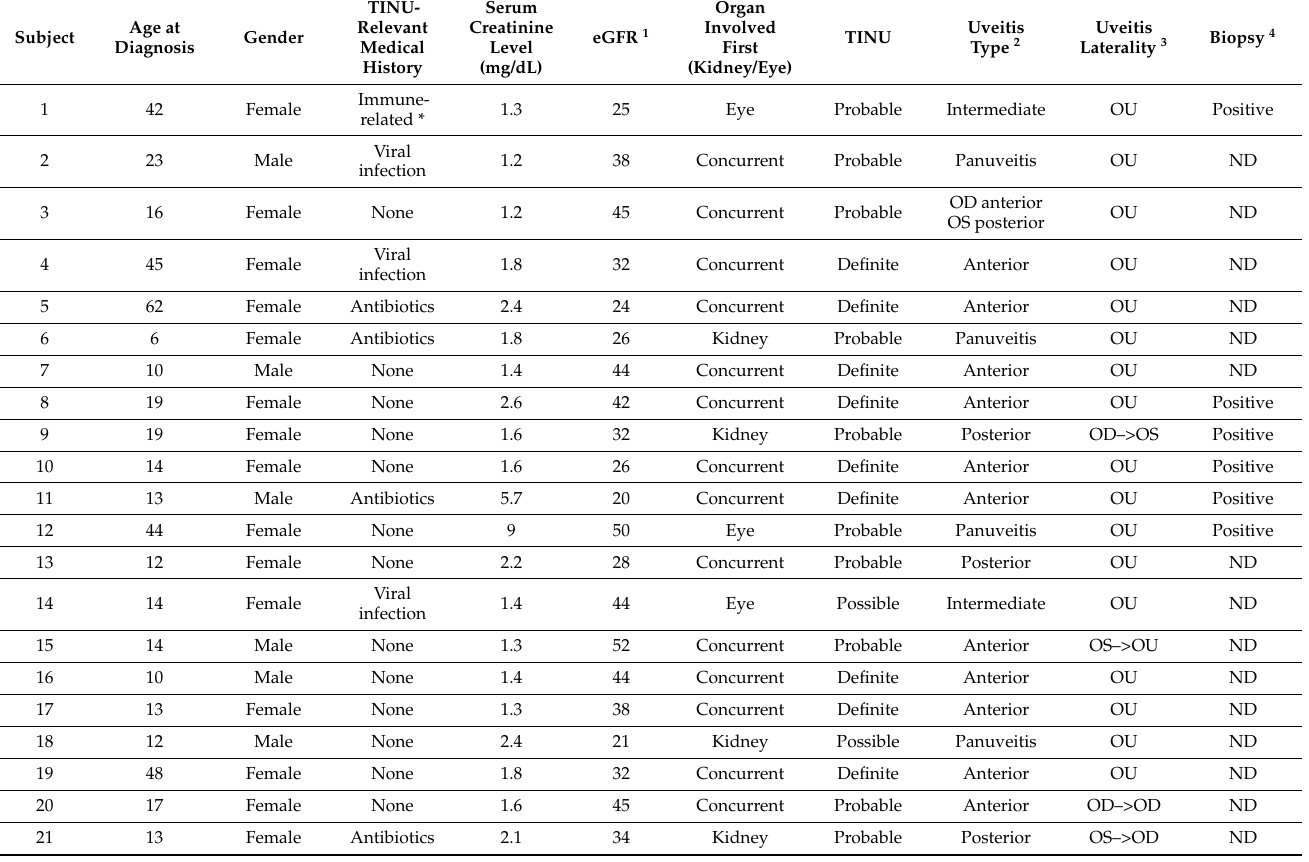
Table 1. Demographic and clinical characteristics of patients. TINU, tubulointerstitial nephritis and uveitis syndrome, eGFR, estimated glomerular filtration rate.